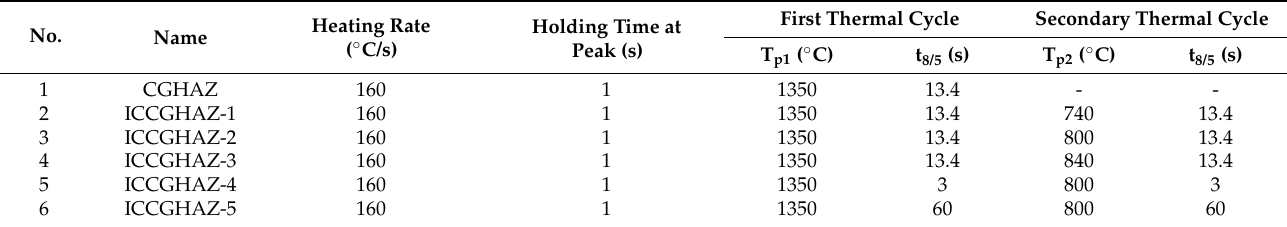
Table 2. Welding thermal simulation